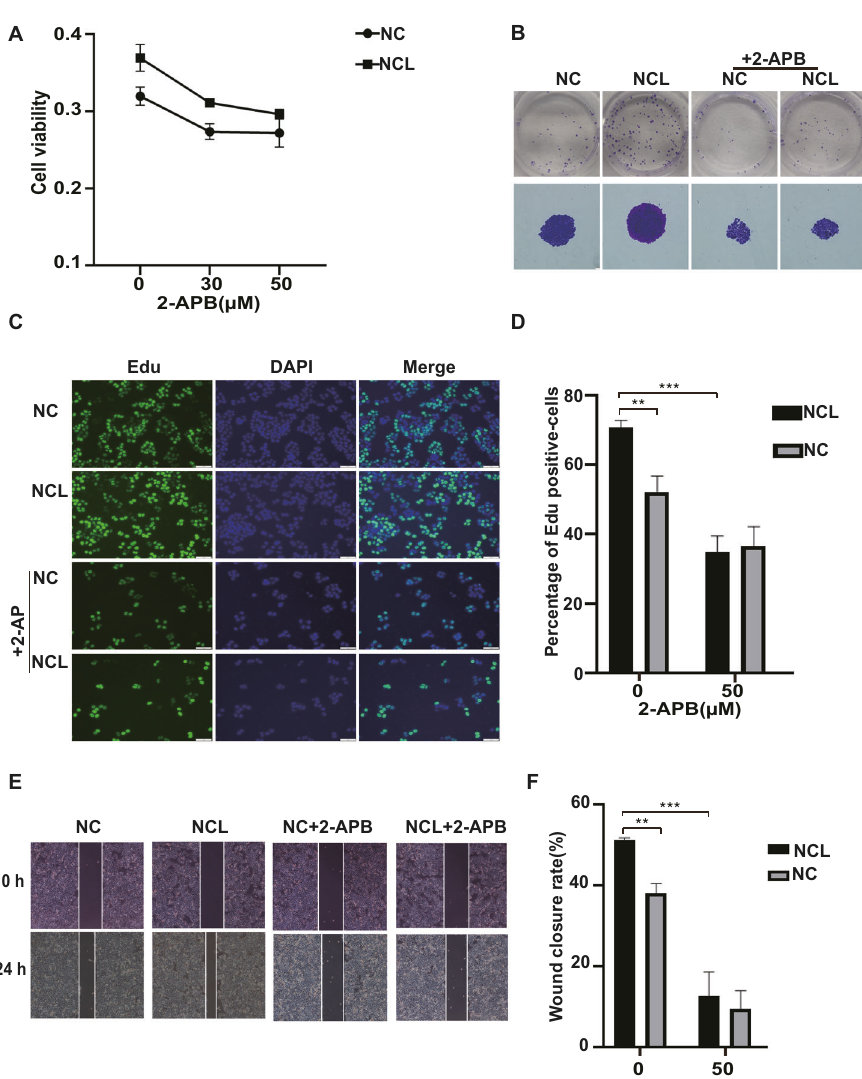
Fig. 5 Inhibition of the calcium in fl ux abolished the promoting effects of NCL on the proliferation of breast cancer cells. A MTT assay assessed the effect of 2-APB on the proliferation of MCF-7 cells stable expression of NCL. MCF-7 cells stable expression of NCL and negative control cells were treated with different concentration of 2-APB, and then the viability of cells was evaluated. B Colony formation assay of MCF-7 cells stable expression of NCL and negative control cells treated with or without 2-APB. C EdU staining for evaluation of the in fl uences of 2-APB on the proliferation of NCL-overexpression MCF-7 cells. Dividing cells were labeled with EdU (green). All cells were counterstained with DAPI (blue). D Quantitative analyses of the percentages of EdU-positive cells. E Scratch assay to evaluate migration ability of MCF-7 cells stable expression of NCL and negative control cells. After cell growth reached con fl uence, a scratch was made by a 200 μ L pipette tip, and cells were treated with or without 2-APB for 24 h. The closure of the scratch was imaged and analyzed. F Wound closure rates were expressed as percentages of the wound area closed at 24 h relative to the initial area at 0 h. All data are shown as mean ± SD. of three replicates. * P < 0.05. ** P < 0.01. *** P < 0.001.